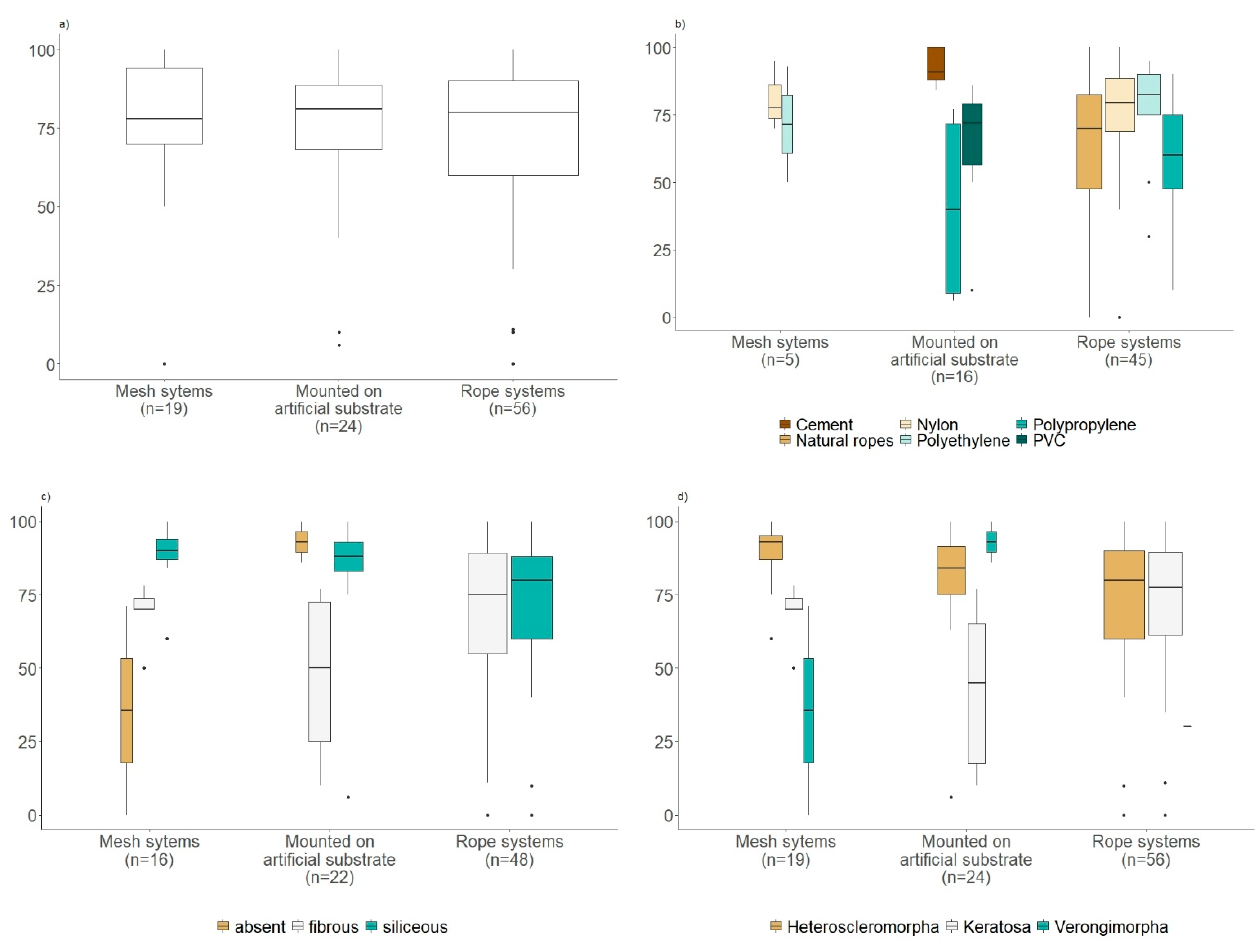
Figure 3. ( a ) Survival rates in percentage in relation to each technique. ( b ) Survival rates in percentage in relation to different techniques and materials (the materials with the highest sample effort were selected where n > 5. Not further defined plastics have been excluded). ( c ) Survival rates in percentage in relation to different methodologies and skeletal consistencies. ( d ) Survival rates in percentage in relation to different techniques and subclasses. (Note: The width of the box plots corresponds to sample size for each group. Only techniques with n > 5 were included in the analysis.